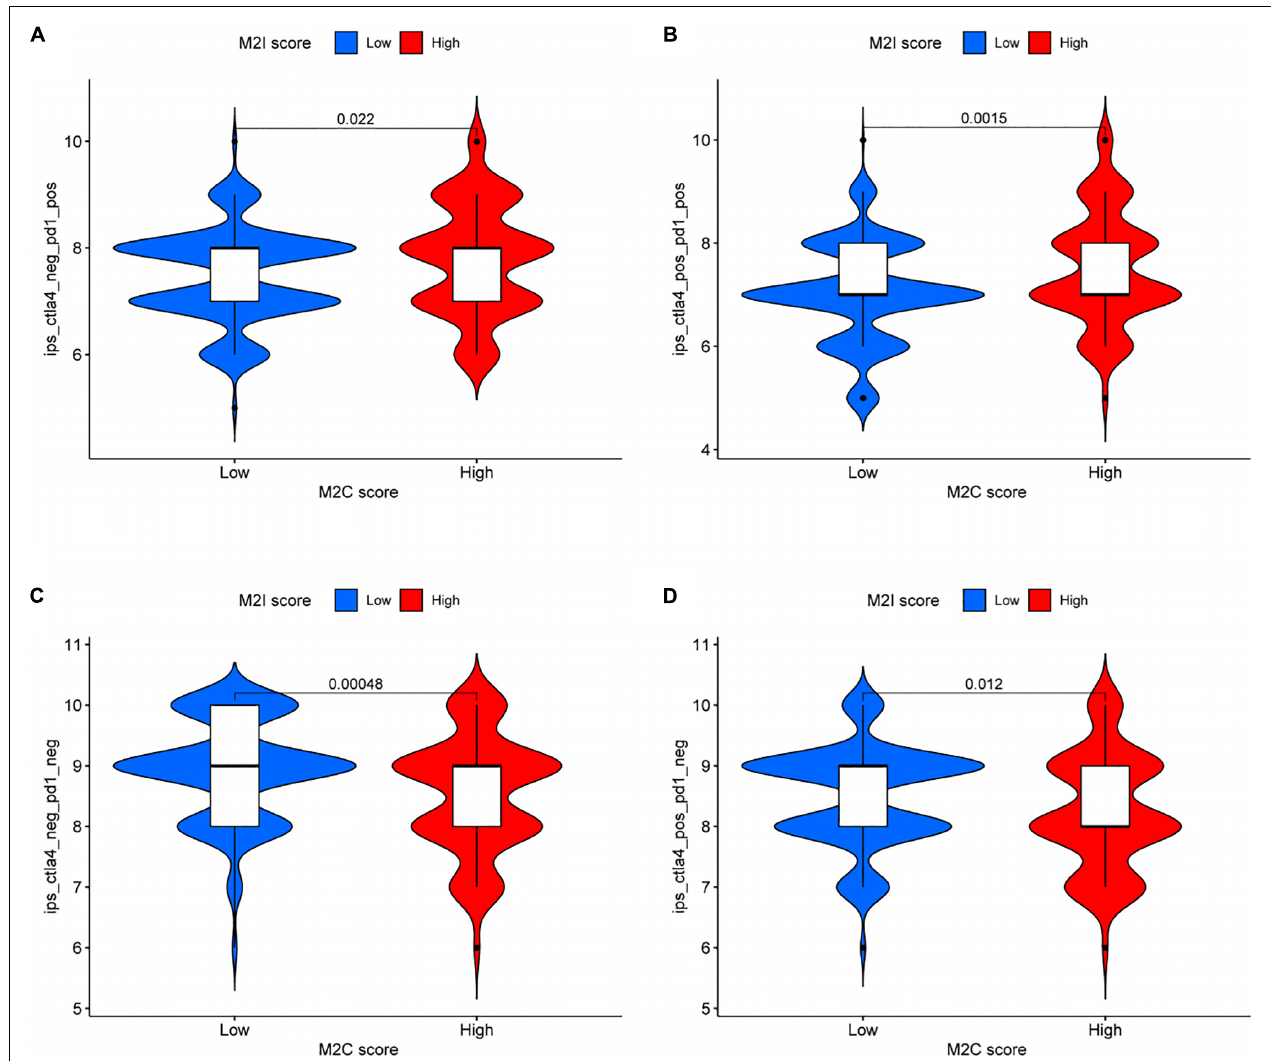
FIGURE 7 | Role of M2I score in predicting immunotherapy benefits. (A–D) Sensitivity of patients with high and low M2I score subgroups to four treatments [ (A) use of PD-1 inhibitor alone; (B) use of PD-1 inhibitor in combination with CTLA-4 inhibitor; (C) do not use immune checkpoint inhibitors; and (D) CTLA-4 inhibitor